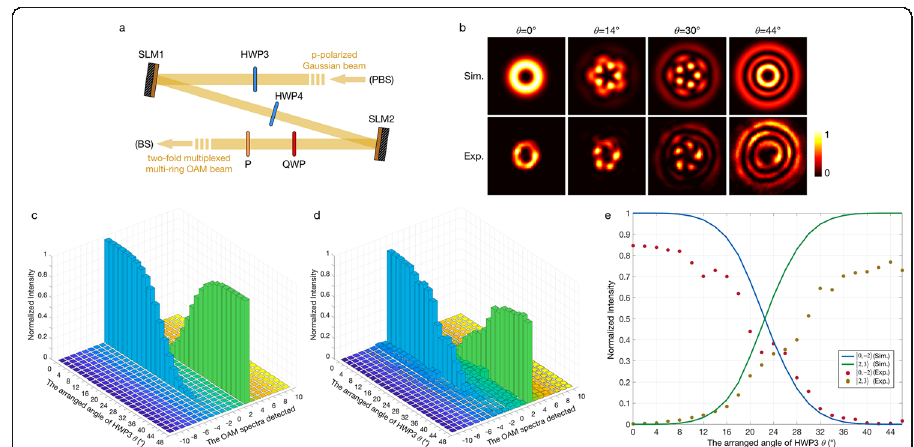
Fig. 5 OAM spectrum analyzing for multi-ring OAM beams. a The schematic setup to generate two-fold multiplexed multi-ring OAM beams. QWP, quarter wave plate; P, polarizer. The two SLMs are encoded by two different holograms to generate | p 1 , − l 1 ⟩ = |0, − 2 ⟩ and | p 2 , l 2 ⟩ = |2, 3 ⟩ respectively. By rotating HWP3, the intensity proportion of the two OAM components be adjusted. b The experimentally recorded intensity profile of two-fold multiplexed multi-ring OAM beams, and their corresponding simulation results. c The simulatively analyzed OAM spectra versus fast axis angle θ of HWP3. d The corresponding experimentally analyzed OAM spectra of ( c ). e The intensity proportion of OAM components |0, − 2 ⟩ and |2, 3 ⟩ versus fast axis angle θ of